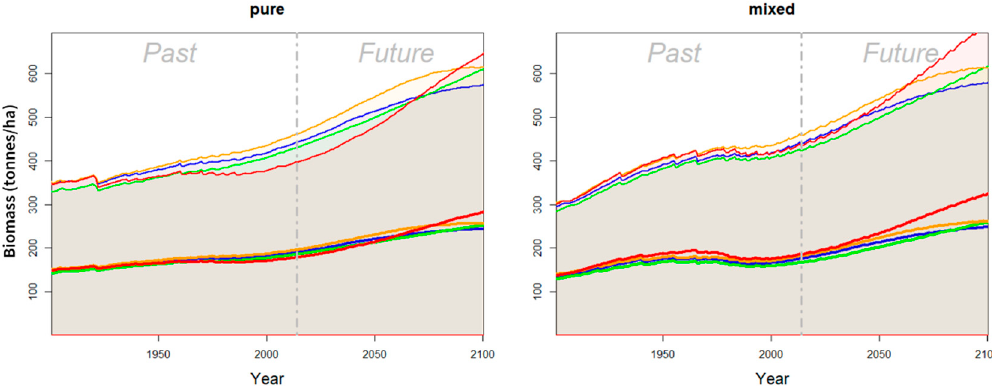
Figure 7. Average quantity of biomass (tonnes/ha—width lines) in pure and mixed forests from 1990 to 2100 and confidence intervals (shaded areas).